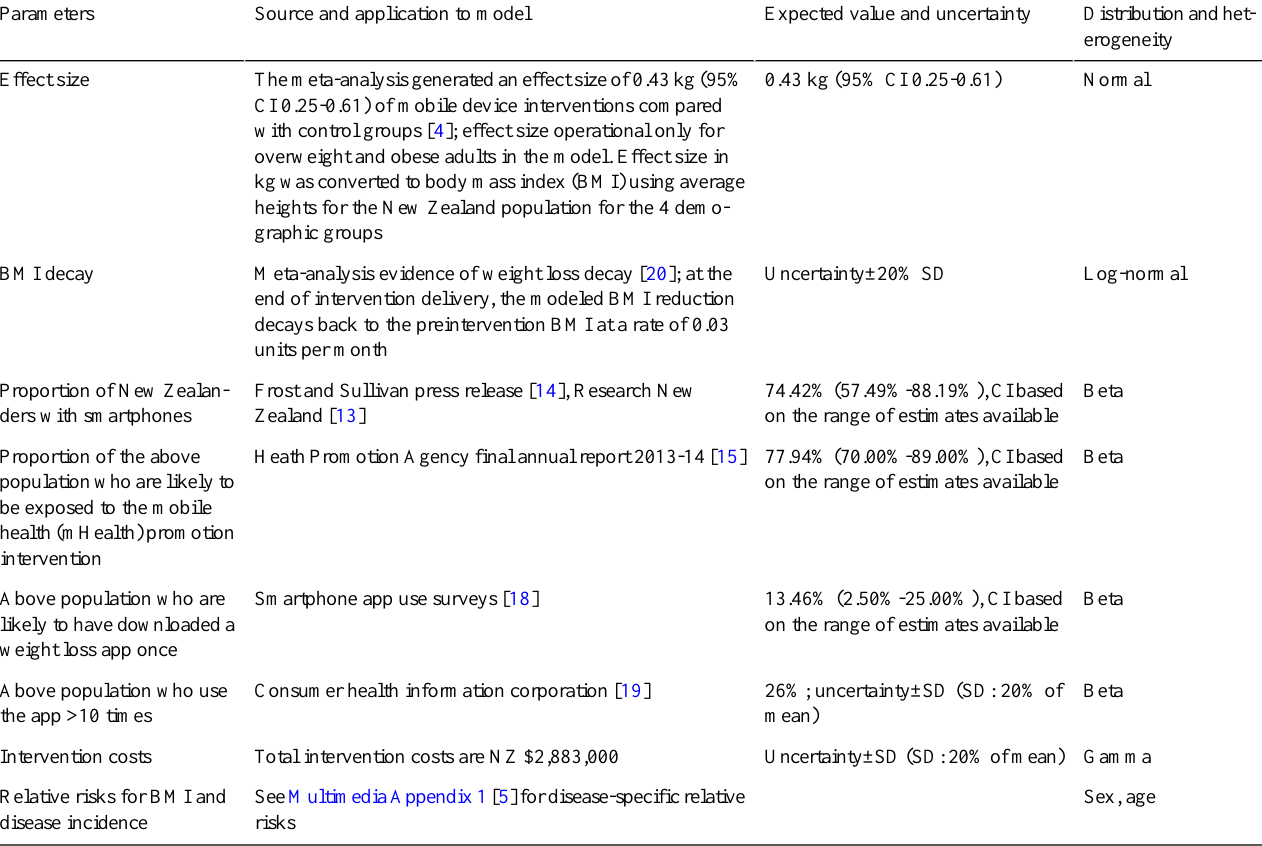
Table 2. Intervention input parameters used in modeling the promotion of smartphone apps for weight loss.